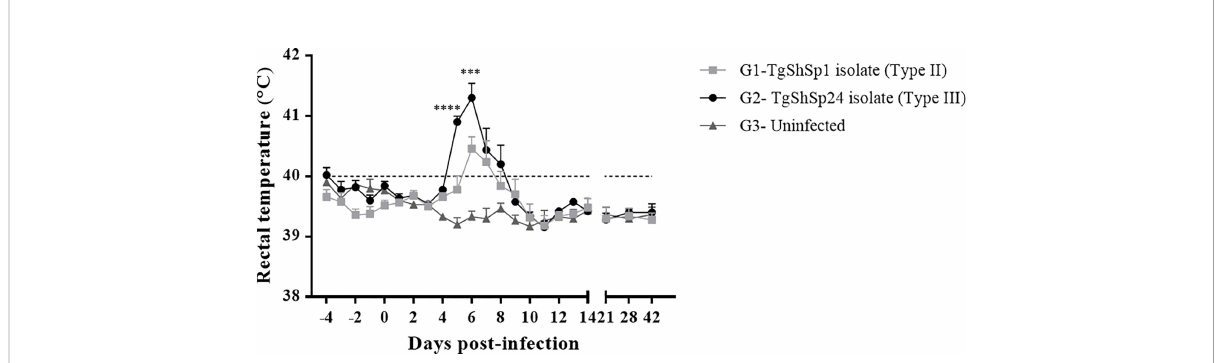
FIGURE 2 Mean rectal temperatures recorded throughout the study. Rectal temperatures of piglets infected with oocysts from TgShSp1 (G1) and TgShSp24 (G2) isolates and uninfected control (G3) animals. Each point represents the mean value at the different sampling times for each group. Error bars represent the SEM. The horizontal dashed line indicates 40°C. Fever was established at values ≥ 40°C. Signi fi cant differences between the infected G1 and G2 groups are indicated with asterisks: *** indicates p < 0.001 and **** indicates p <